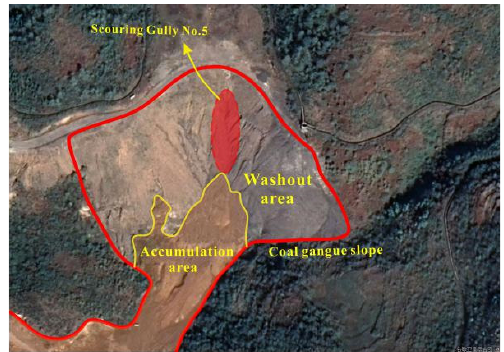
Figure 2. Top view of the site.